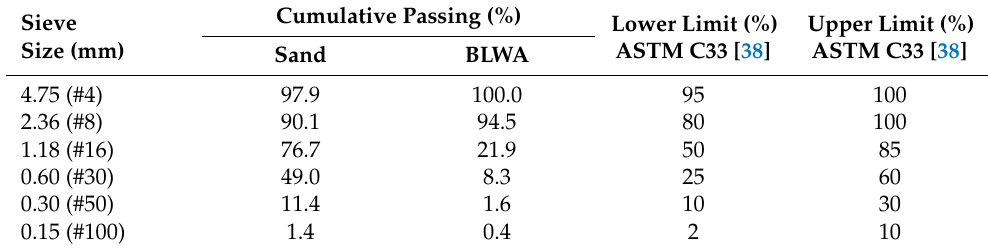
Table 3. Sieve size and cumulative passing of fine aggregates.